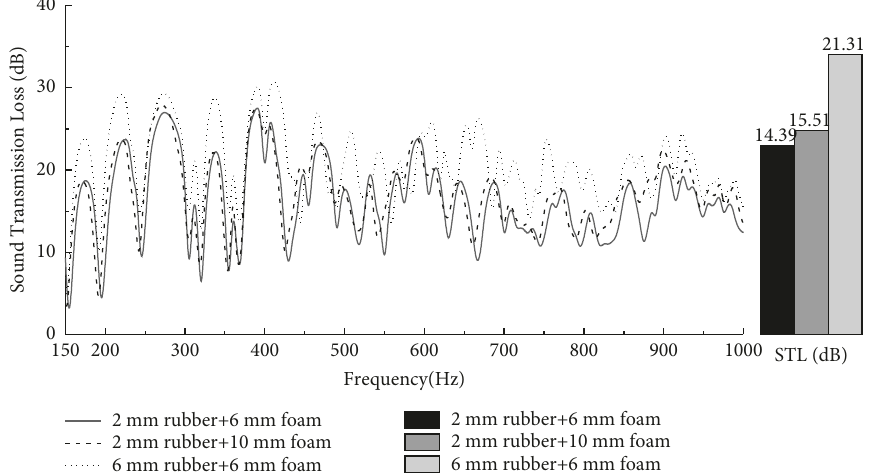
Figure 10: Comparison of multilayer combination material thickness on sound transmission loss of the cylindrical